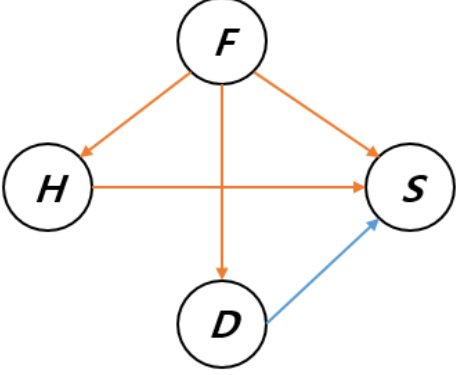
Figure 7. Example of Bayesian Network [26]. Table 1. Conditional Probability P( H/F ) [26].